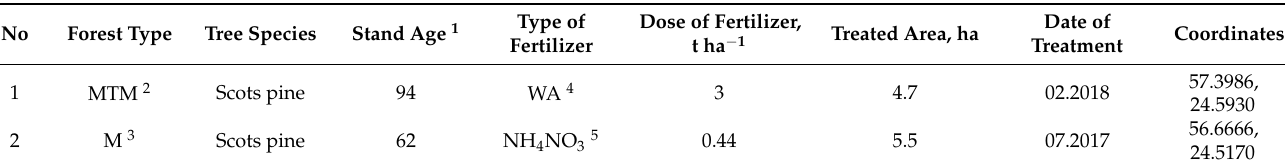
Table 1. Characteristics and treatments of the studied forest stands located at two hemiboreal streams in Latvia.